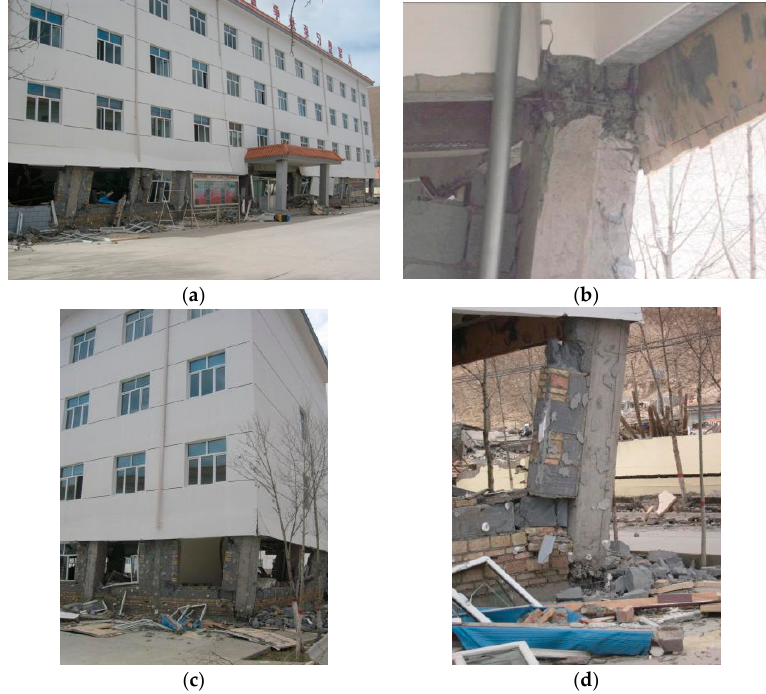
Figure 2. Seismic damage of the prototype building. ( a ) Bottom weak story mechanism; ( b ) ‘Strong beam–weak column’ mechanism; ( c ) Non-uniform damage along the height; ( d ) Damage at the bottom column root.